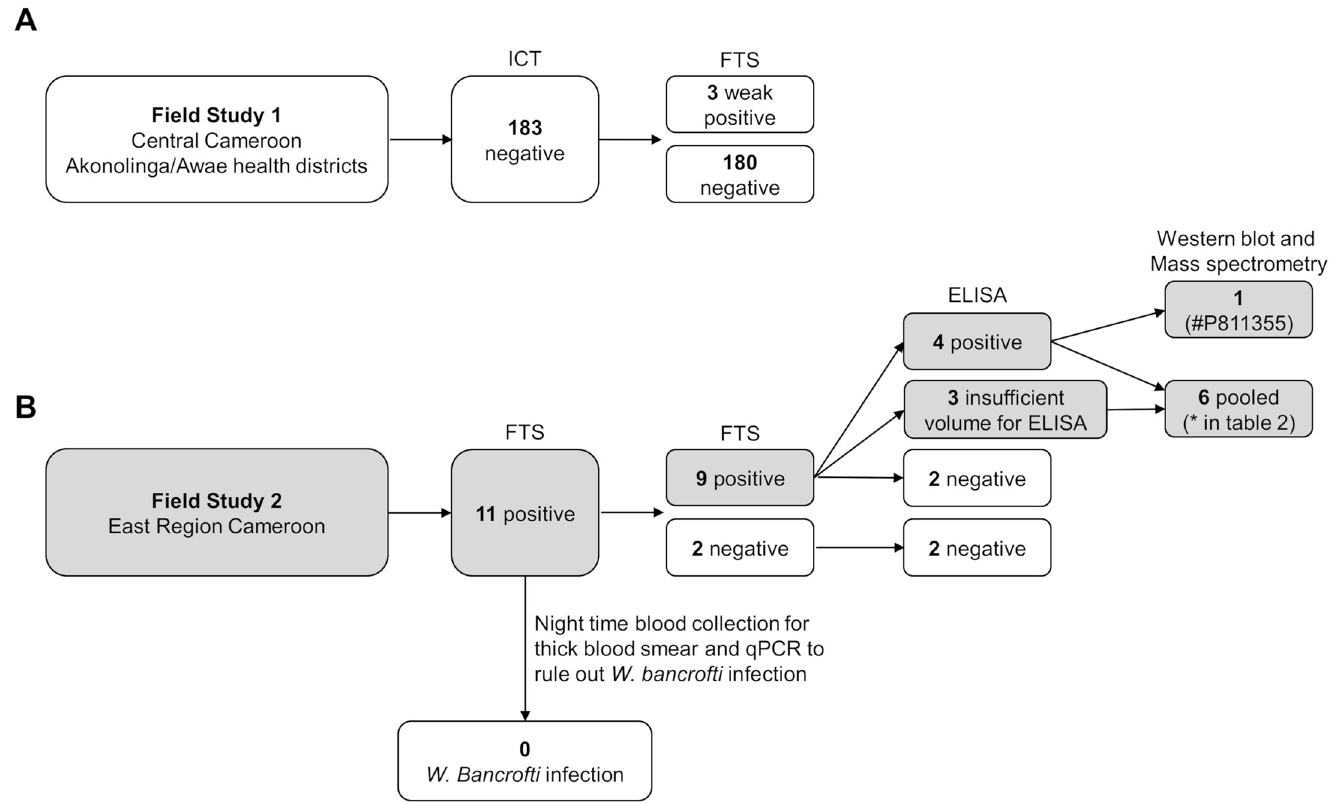
Fig 1. Field studies and samples tested. (A) Central Cameroon field study. Because the three FTS positive samples were very weakly positive by FTS and negative by ICT, we chose not to examine them further. (B) East Region study. Participants who were ICT-positive on initial screening were visited the following week for venous blood collection. Nine venous blood samples were FTS-positive. Two of these tested negative for filarial antigen by ELISA; the other seven were tested further by ELISA and/or western blot as indicated. Gray shading indicates the origin of the samples used in the proteomic